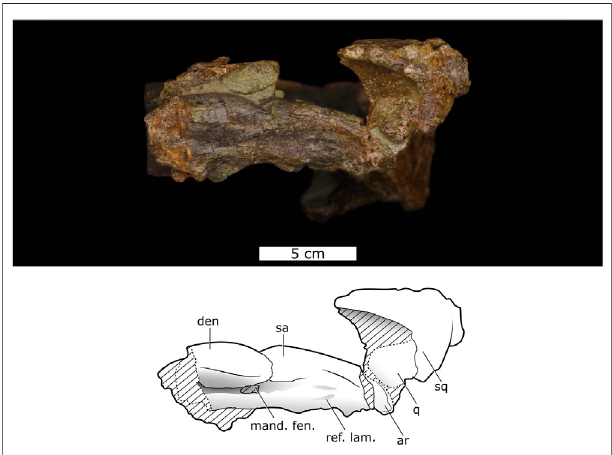
FIGURE 4 | Lateral view of Lanthanostegus specimen BP/1/8209 showing the lower jaw.